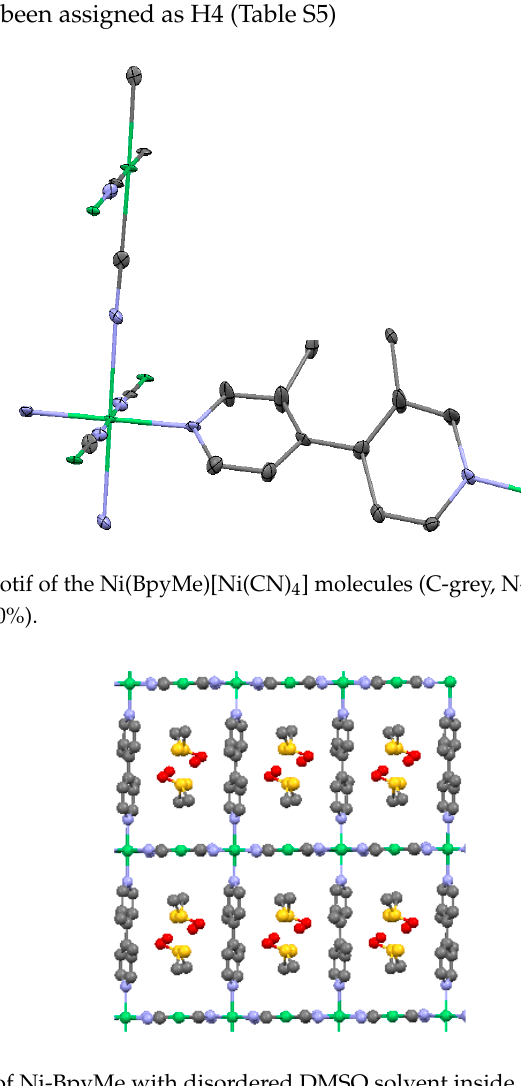
Figure 10. Structure of Ni-BpyMe with disordered DMSO solvent inside the rectangular cage (view along the b-axis; C-grey, N-blue, Ni-green, S-yellow,